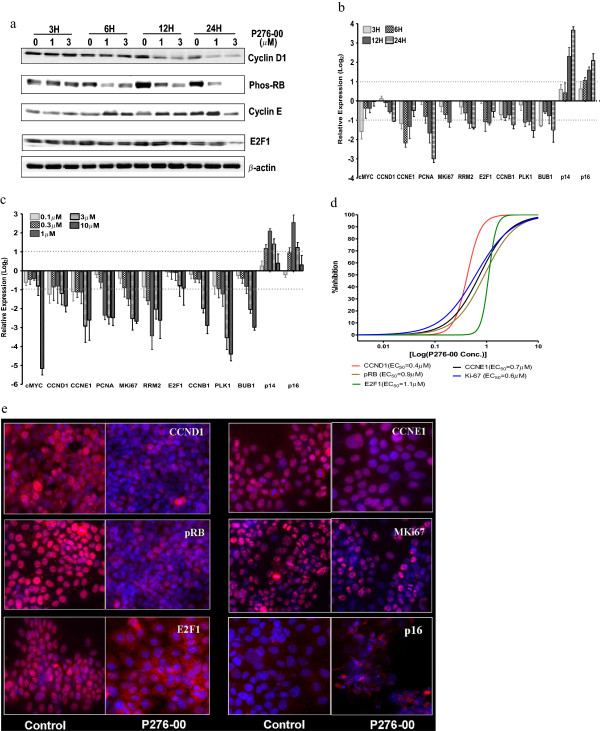
P276-00 targeting CCND1/pRB mediated E2F1 pathway and causing G1 arrest in FaDu cells. (a) Western blot analysis of CCND1, pRb, CCNE1 and E2F1 in FaDU cells treated with 1 and 3 μM P276-00 for 3, 6, 12 and 24 hours.(b-c) RTQPCR based transcript profiling of various downstream targets of E2F1 pathway. Data is represented on log2 scale as mean ± S.E.M. (n=3-5). (b) Dose response - FaDu cells were exposed to 5 different concentrations of P276-00 (range: 0.1-10 μM) for 12 hours in FaDu cells. (c) Time response- cells were exposed to 4 different time points (3, 6, 12 and 24 hours) with 1 μΜ of P276-00 (d-e) Automated fluorescence imaging based dose dependent protein profiling of CCND1/pRB mediated E2F1 pathway and its downstream targets. FaDu cells (1–2 × 104 cells/ml) were treated with 8 different concentrations of P276-00 (range 0.03 to 10 μM) for 24 hours and observed using ArrayScan HCS reader after staining with respective antibody (d) Quantification of the automated fluorescence imaging data has been represented in sigmoidal dose response curve where compound concentration. is represented in log2 scale. One thousand cells were counted for each replicate well and the results were presented as an average ± S.E.M. (n = 3). EC50 values have been generated for all the 5 proteins. (e) Panel of representative images.